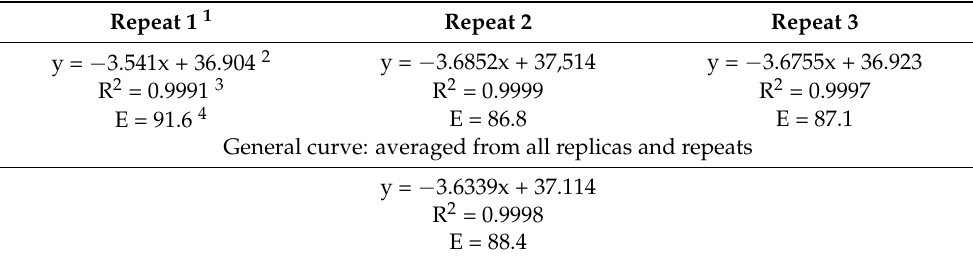
Table 5. Reliability of the quantification using pDNA as